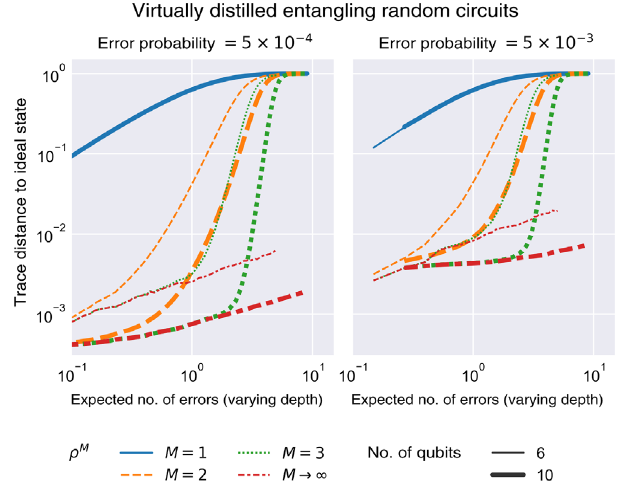
FIG. 5. The error in the unmitigated noisy states ( M ¼ 1 ), the states accessed by virtual distillation ( M ¼ 2 , 3), and the dominant eigenvector of the density matrices ( M → ∞ ) for a variety of entangling random circuits. We plot the trace distance to the state obtained from noiseless evolution as a function of the expected number of single-qubit depolarizing errors for two different system sizes (represented by thickness of marker). Here we vary the expected number of errors by varying the number of gates, fixing the single-qubit depolarizing probabilities to 5 × 10 − 4 (left panel) or 5 × 10 − 3 (right panel). We see that the dominant eigenvector determines the noise floor beyond which we cannot improve, independent of the number of copies, and that this floor drops as the size of the system increases.